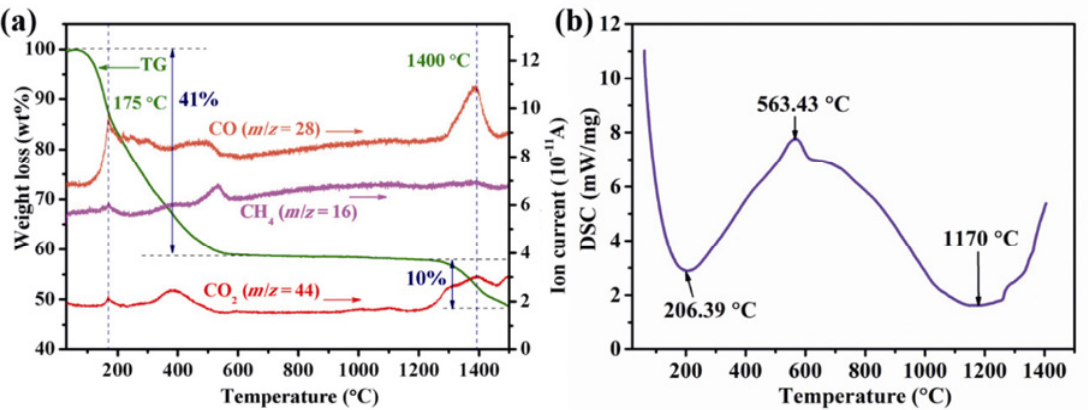
Fig. 4 Polymer-to-ceramic transformation of the HfC precursor. (a) In situ TG–MS test; (b) DSC